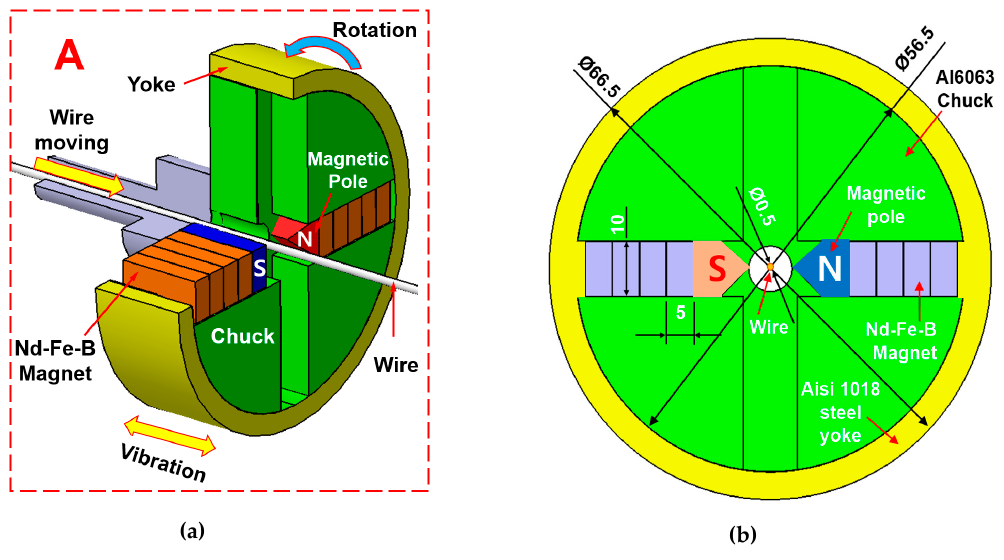
Figure 2. Magnetic abrasive finishing equipment for beta-titanium wire using Nd-Fe-B permanent magnet.